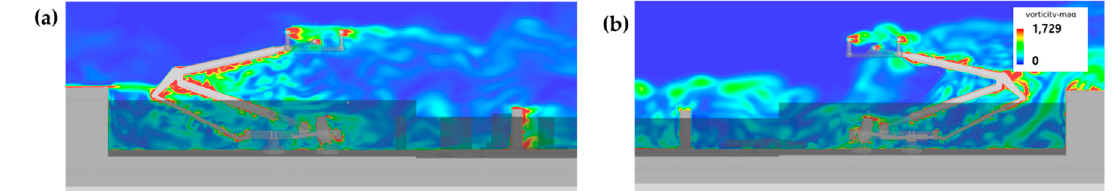
Figure 11. Simplified roof fairing and pantograph models: ( a ) first pantograph and roof pairing on the M1 car; ( b ) second pantograph and roof fairing on the M3 car.